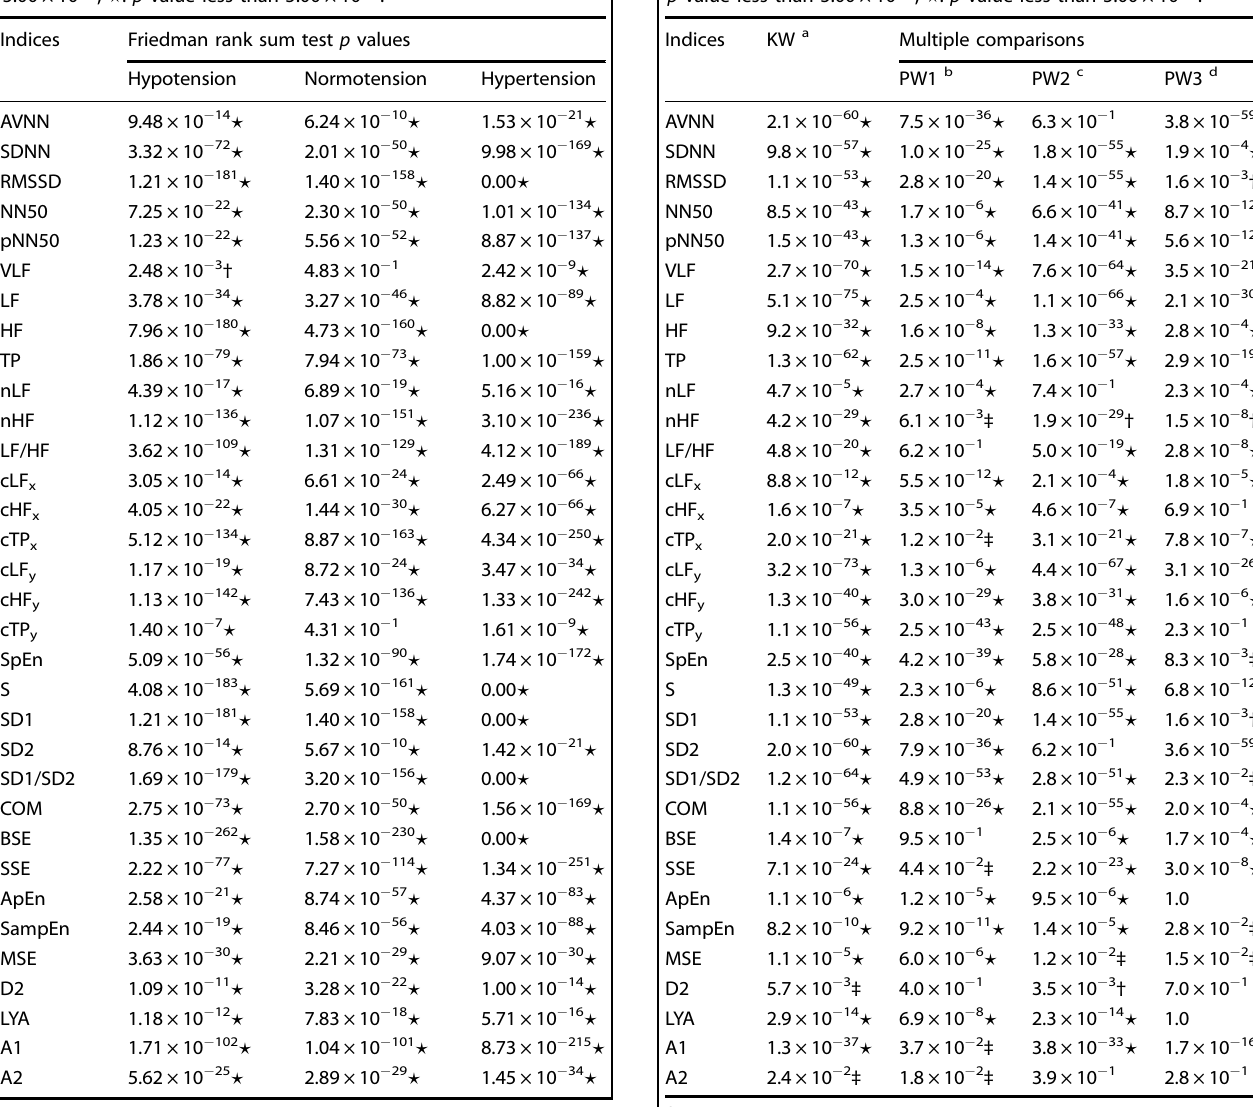
Table 3. Friedman rank sum tests results for the comparison between pulse rate variability and heart rate variability in the different blood pressure states. ‡ : p value less than 5.00 × 10 − 2 ; † : p value less than